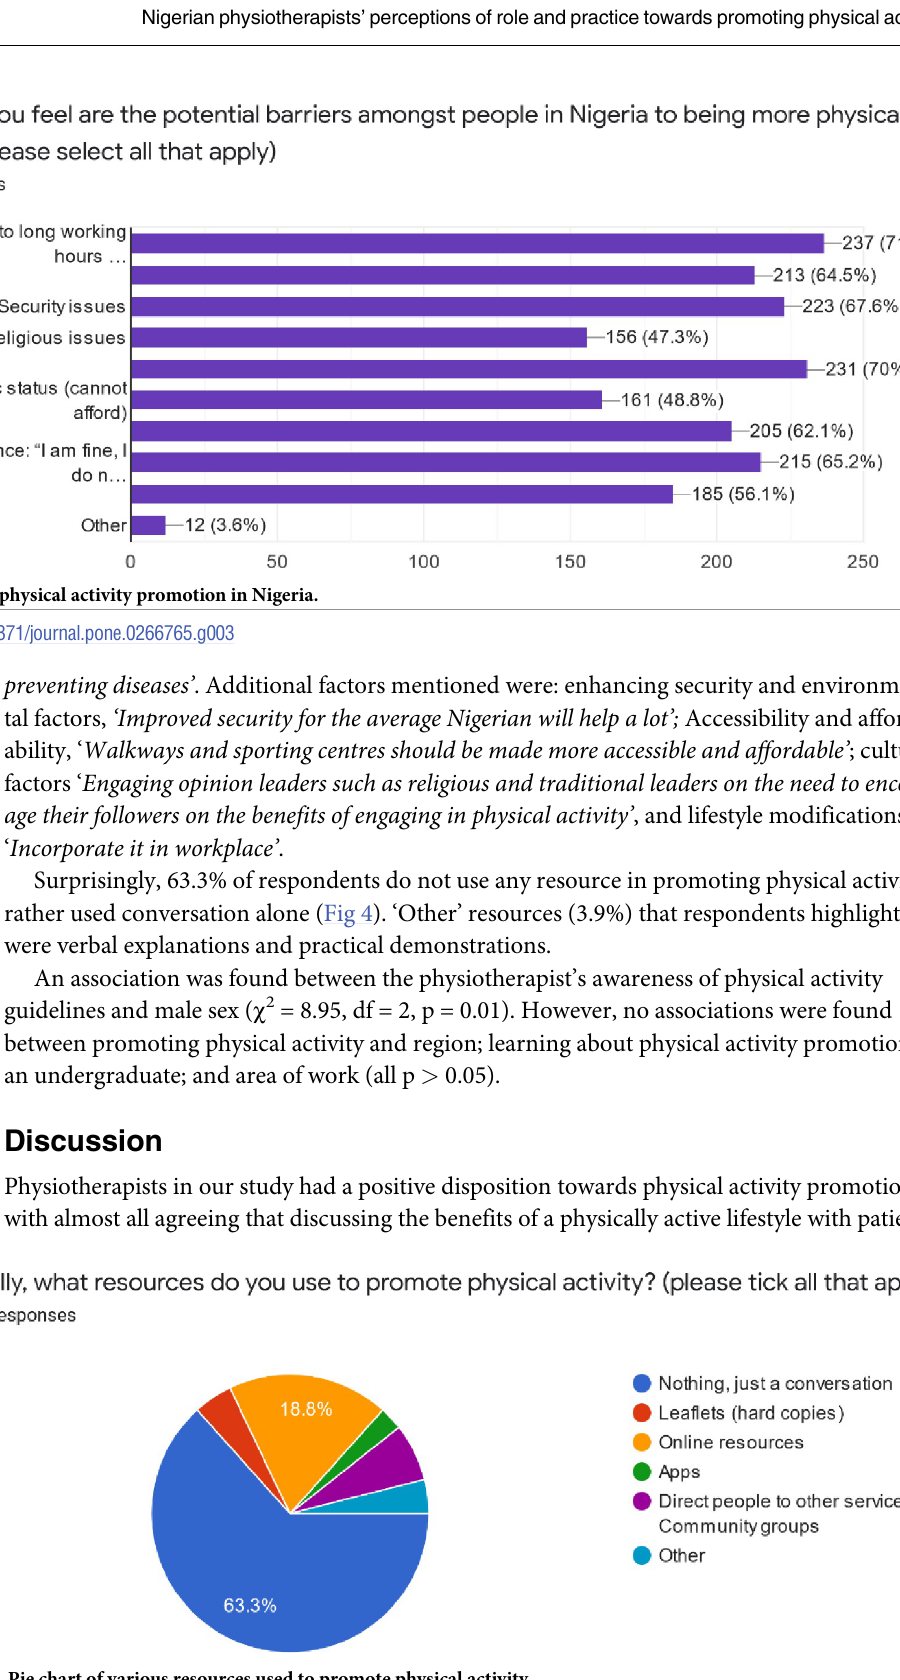
Fig 4. Pie chart of various resources used to promote physical